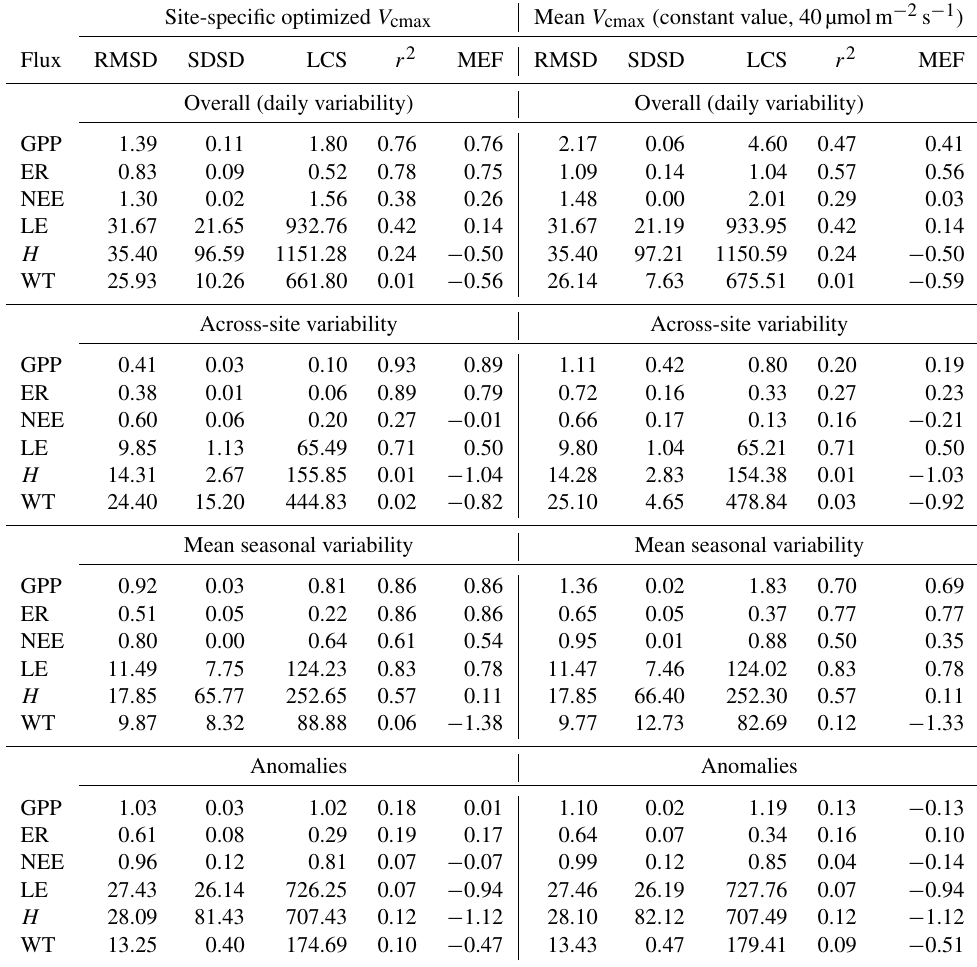
Table 4. Model performance measures for GPP, ER, NEE, LE, H , and WT. The left-hand column shows results with site-specific optimized V cmax at each site; the right-hand column shows results with the fixed V cmax (40µmolm − 2 s − 1 ) at all